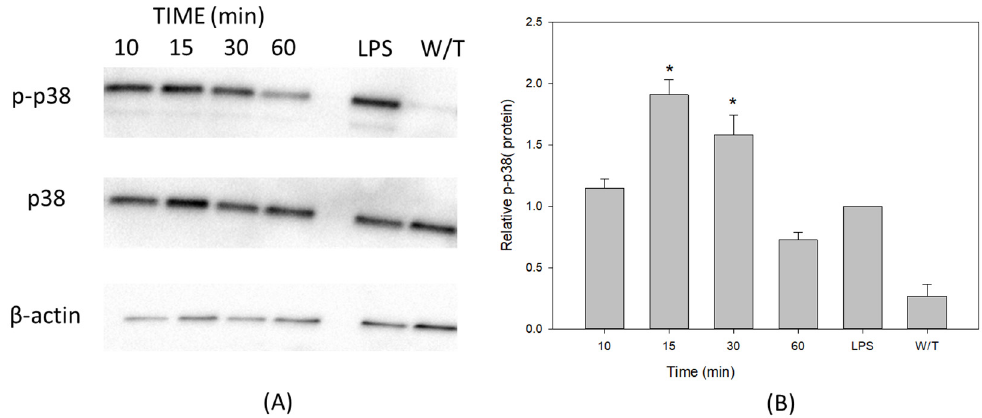
Figure 3. VCC activates the phosphorylation of p38 in THP-1 macrophages. THP-1 macrophages were treated with 40 pg/mL of VCC at 10, 15, 30 and 60 min. A positive control of LPS (1 µ g/mL) was used. Cell lysates were analyzed by the Western blot assay. ( A ) Phosphorylation of p38 after treatments with VCC. The results illustrated here are from a single experiment representing three separate experiments. In the upper panel of the Western blot, changes in the phosphorylation of P-p38 were identified, while in the middle panel, it is observed that the content of non-phosphorylated p38 appears constantly in all the analyzed samples. The lower panel shows the β -actin protein considered an internal control. ( B ) Kinetic of treatment with VCC. Results in the graphic are representative of three performed experiments. W/T, without treatment. Mean ± SD. * p < 0.001, significantly different from the group treated with LPS (ANOVA plus the Student–Newman–Keuls